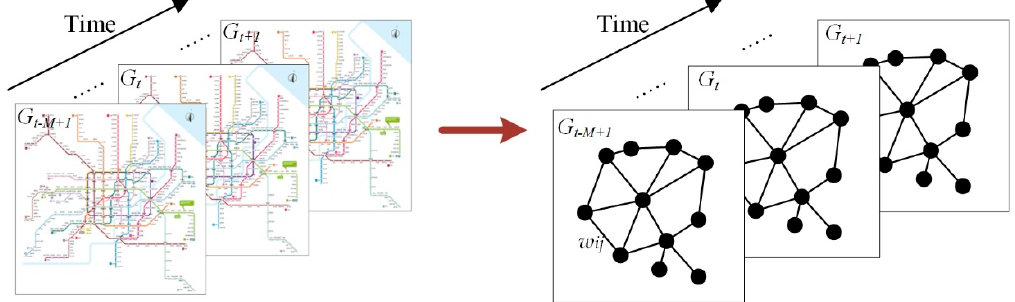
Figure 1. Graph-structured metro passenger flow-volume data. At the time step t , in the graph G t = ( V t , E , W ) , V t is an observation vector of n metro stations at time step t , each element of which records the historical passenger flow volume for a single metro station; E is a set of edges, indicating the connectedness between stations; while W ∈ R n × n denotes the weighted adjacency matrix of G t .